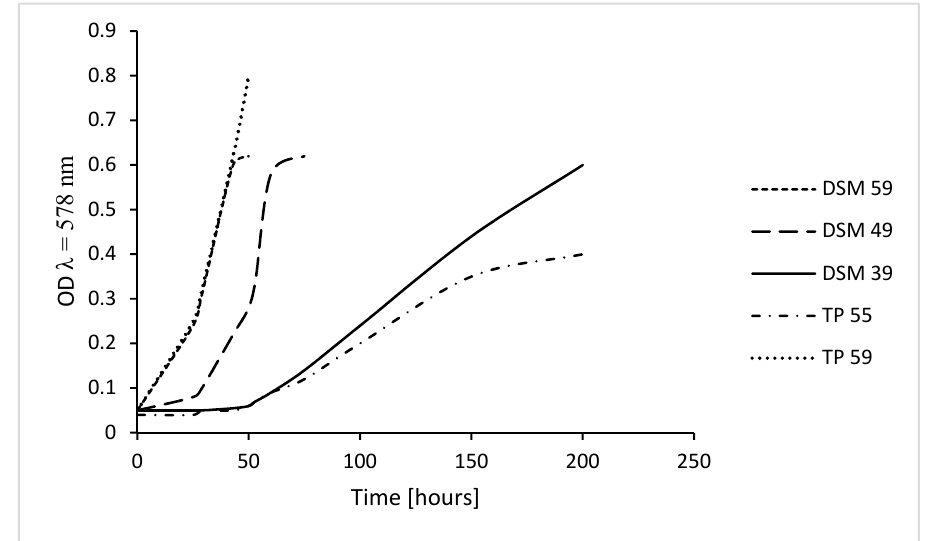
Figure 1. Culture growth of Thermoplasma. Growth of Thermoplasma acidophilum DSM 1728, Göttingen, Germany, at 39 °C, 49 °C, and 59 °C and of wild type Thermoplasma harvested from a Tangkuban Perahu crater, grown at 55–56 °C in 1-Liter culture flasks without automated control (TP 55); growth of the latter is similar to that of the former at 39 °C to a maximum OD of 0.35–0.4 and at 59 °C in a computer-regulated 2-L fermenter (TP 59); OD, optical density at λ = 578 nm; in all cultures, pH was below 2 (at the beginning of the cultures adjusted to 1.5 and re-adjusted, if necessary); values adapted from [11,12].